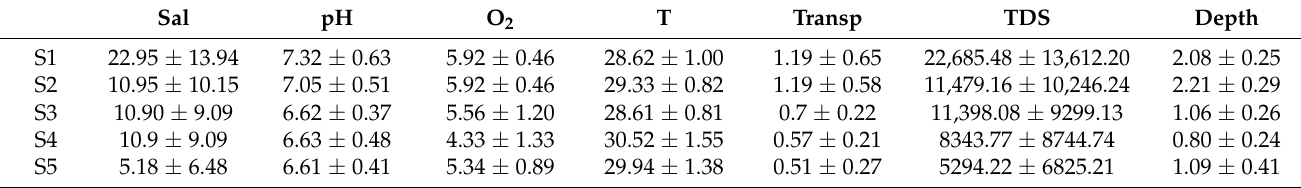
Figure 2. Spatial fluctuations (annual average) of environmental variables at the different stations, S1: south, S2: centre S3: west, S4: north, S5: east. See Figure 1 for positions of these stations. Table 2. Annual mean and standard deviation of the different parameters at the 5 stations.